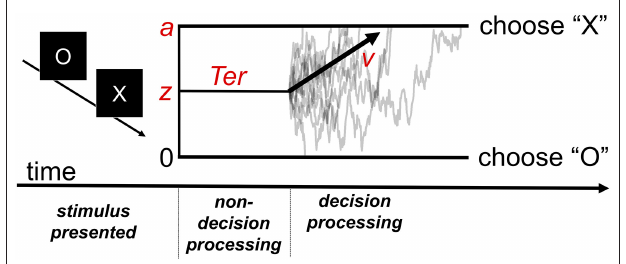
FIGURE 1 | The diffusion decision model (DDM). The model explains performance in a simple decision task in which participants must decide whether the stimulus presented was an “X” or “O.” Following stimulus presentation, the decision process drifts between the boundaries for each possible response. Gray traces represent the paths of the stochastic decision processes for individual trials. The black arrow represents the critical drift rate parameter, v , which determines the average rate at which the process drifts toward the correct response boundary (e.g., toward an “X” response on a trial in which an “X” stimulus was presented). The z parameter represents the starting point bias of the process (in the example, it is set midway between the two decision boundaries representing absence of bias). The a parameter determines where the upper boundary is set (with the lower boundary always set at 0) and can be used to index “response caution,” the quantity of evidence that is required before the decision boundary is reached. The model also includes a parameter for time spent on processes peripheral to the decision ( Ter